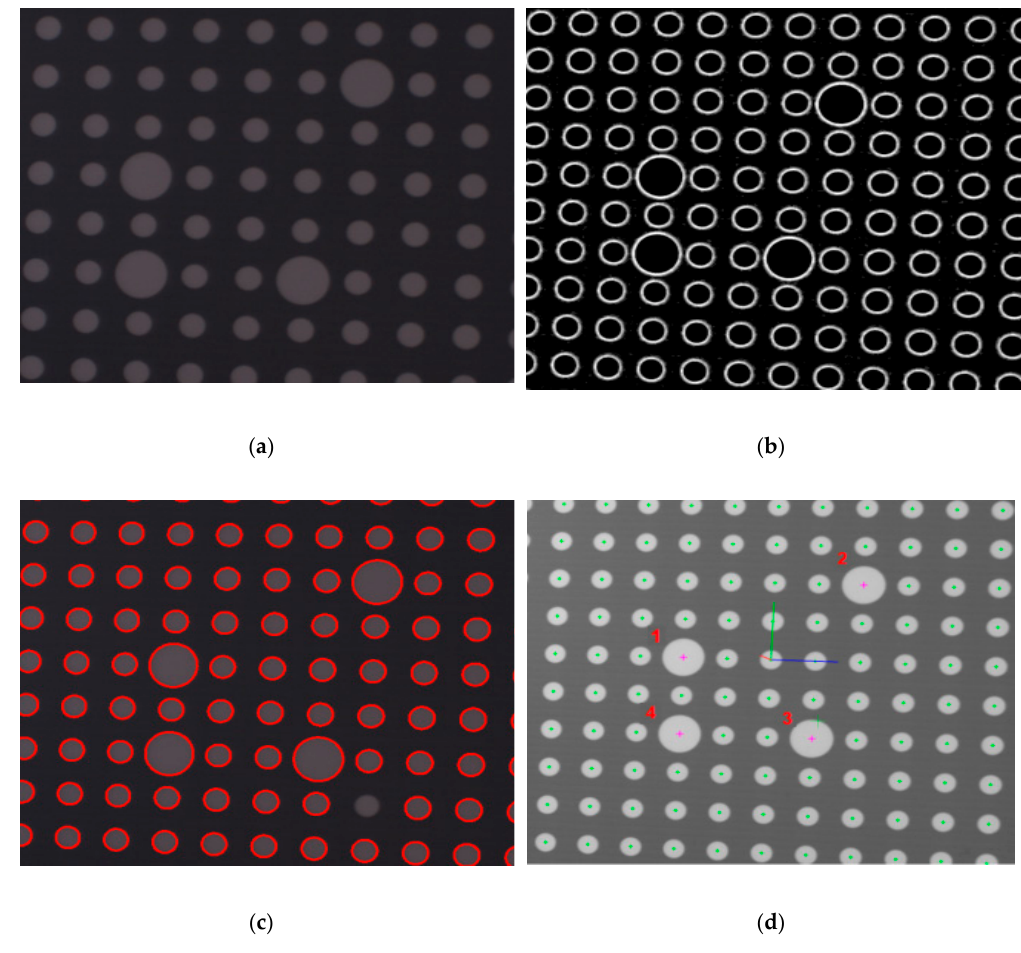
Figure 3. Pattern detection and pose estimation. ( a ) Original image, ( b ) edge detection, ( c ) ellipse fitting, ( d ) pose